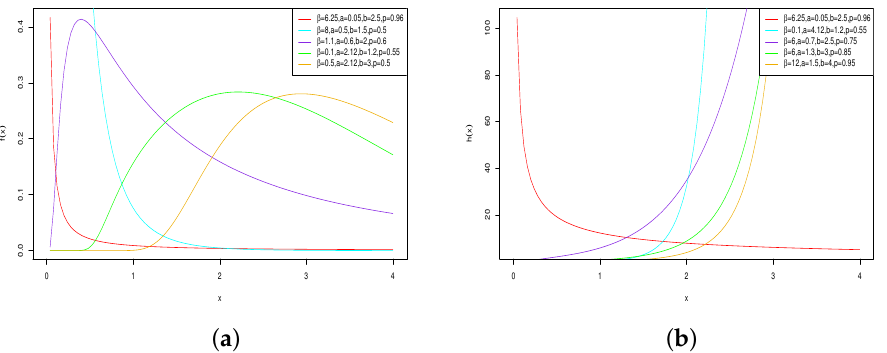
Figure 3. Examples of plots of the ( a ) pdf and ( b ) hrf of the OELF distribution for various values of p , β , a and b